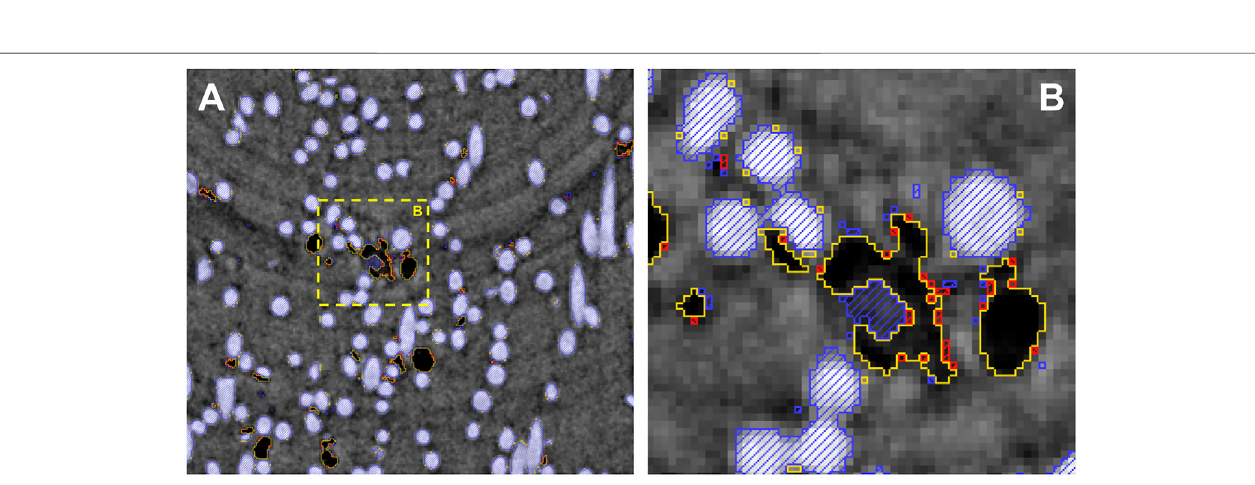
FIGURE 4 | Segmentation generated by the 2D model on the test set. Phase color code: blue represents voxels correctly classi fi ed as fi ber (hatched), yellow as porosity (contours), and red represents misclassi fi cation. Notice that some regions in blue are in fact mistakenly segmented as fi ber, although it is considered as correct because the annotations contain the same mistake. (B) is a zoom of the yellow-countoured area in (A) .